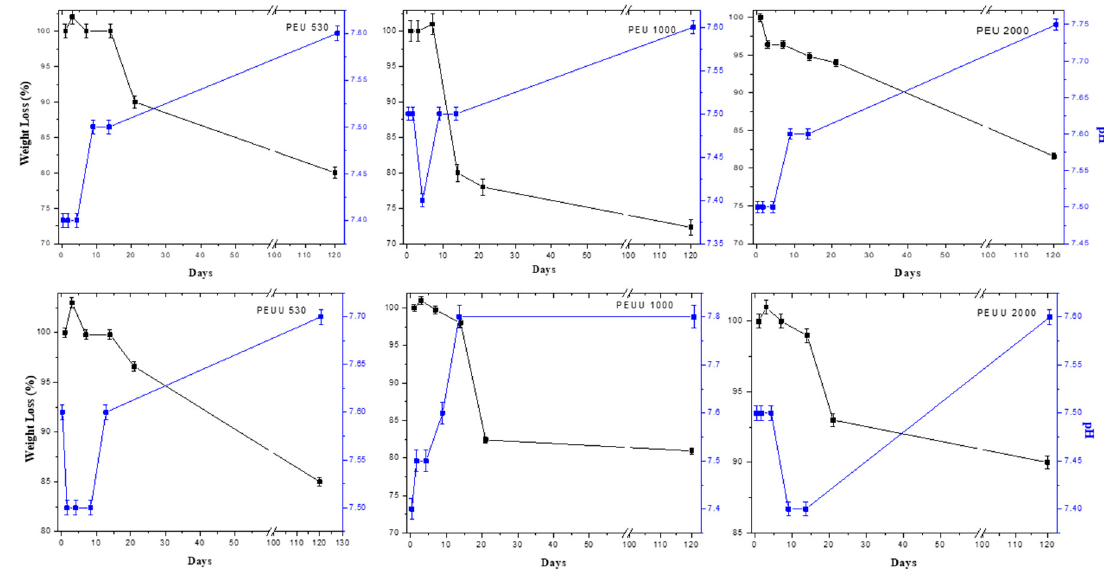
Figure 6. pH and weight changes of polymers submerged in PBS.